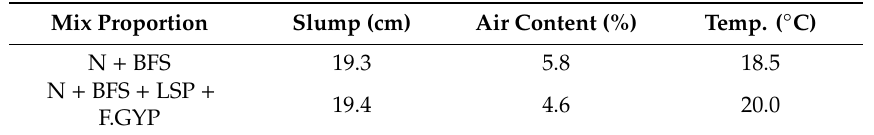
Table 4. Fresh concrete properties.